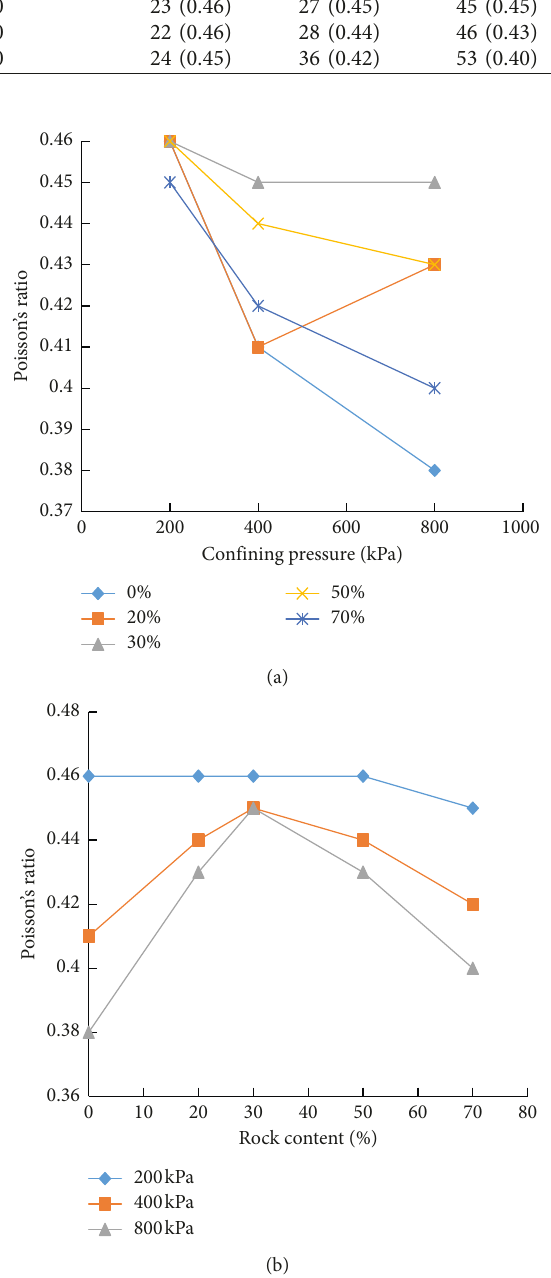
Figure 6: Poisson’s ratio variation at different confining pressures (a) and rock percentages